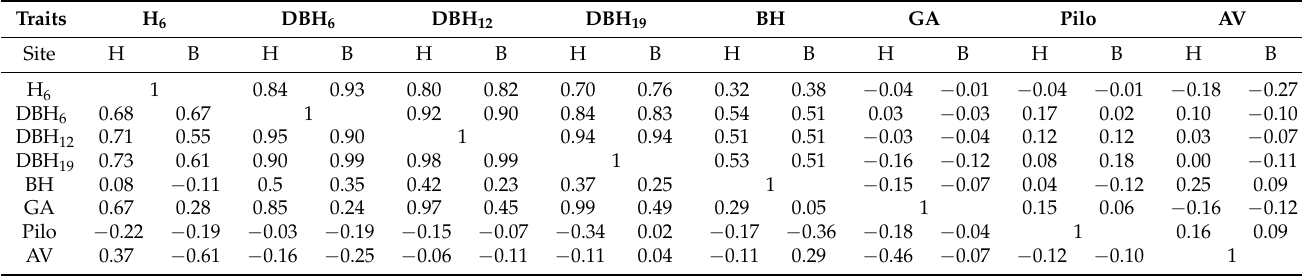
Table 3. Phenotypic (above the diagonal) and additive genotypic (below the diagonal) correlations between traits. H is Hyssna and B is for